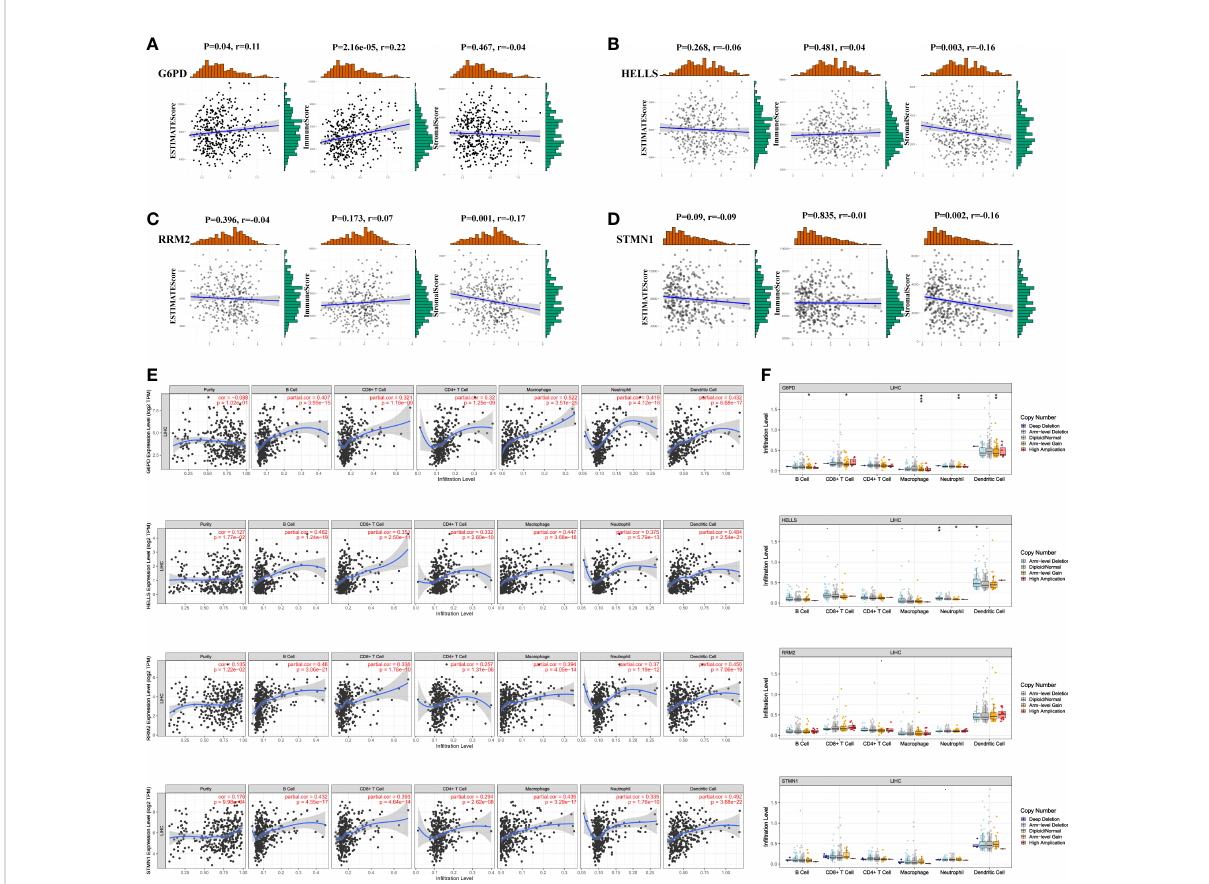
FIGURE 9 Association of four FRGs ’ expression with immune in fi ltration level in HCC. (A – D) Association between immune/stromal/estimate score and four FRGs after ESTIMATE algorithm processed. (E) Correlation of FRGs including G6PD, HELLS, RRM2, and STMN1 with tumor purity and tumor in fi ltration immune cells. (F) The in fl uence of copy number variation of G6PD, HELLS, RRM2, and STMN1 on the distribution of diverse in fi ltration immune cells. *P <0.05; **P <0.01; ***P